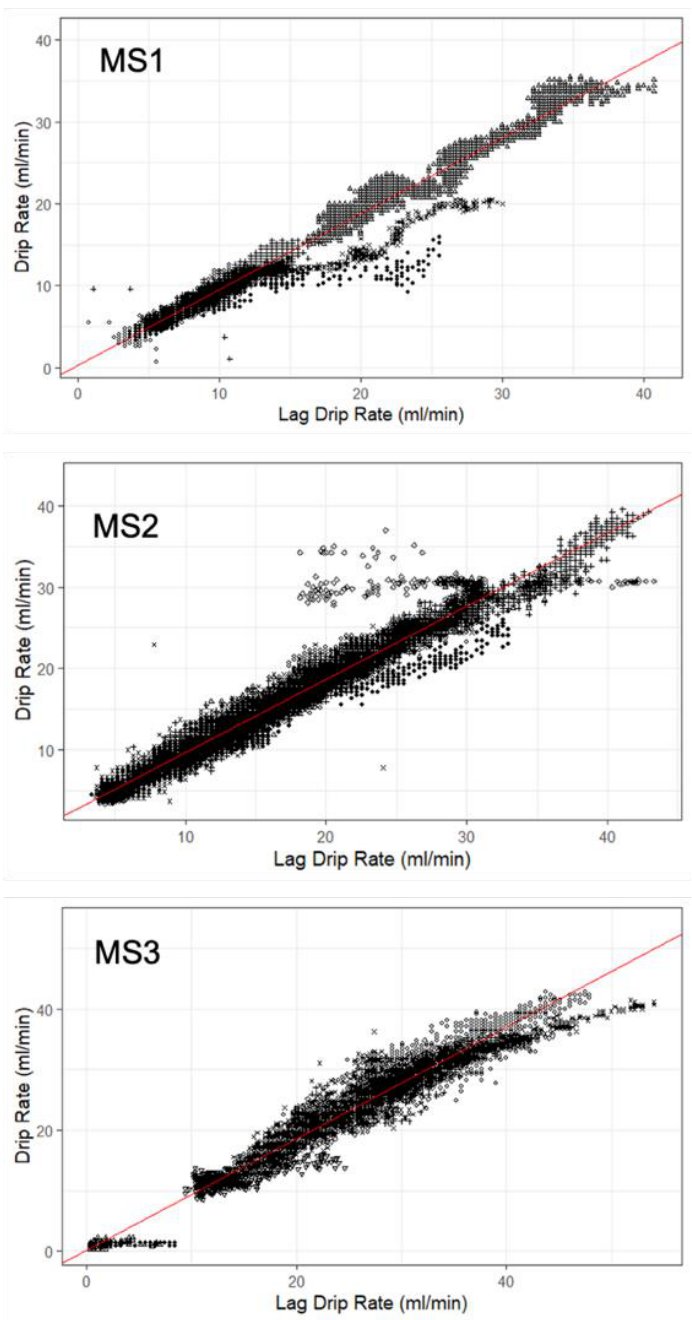
Figure 3. Drip rate (mL/min) vs. lag drip rate (mL/min) for baseflow (Q < 50 mL/min) in MS1, MS2, and MS3 plotted with data correlated by 1 day lag time. Envelope line plotted by least squares regression model, fitted for minimum residuals.